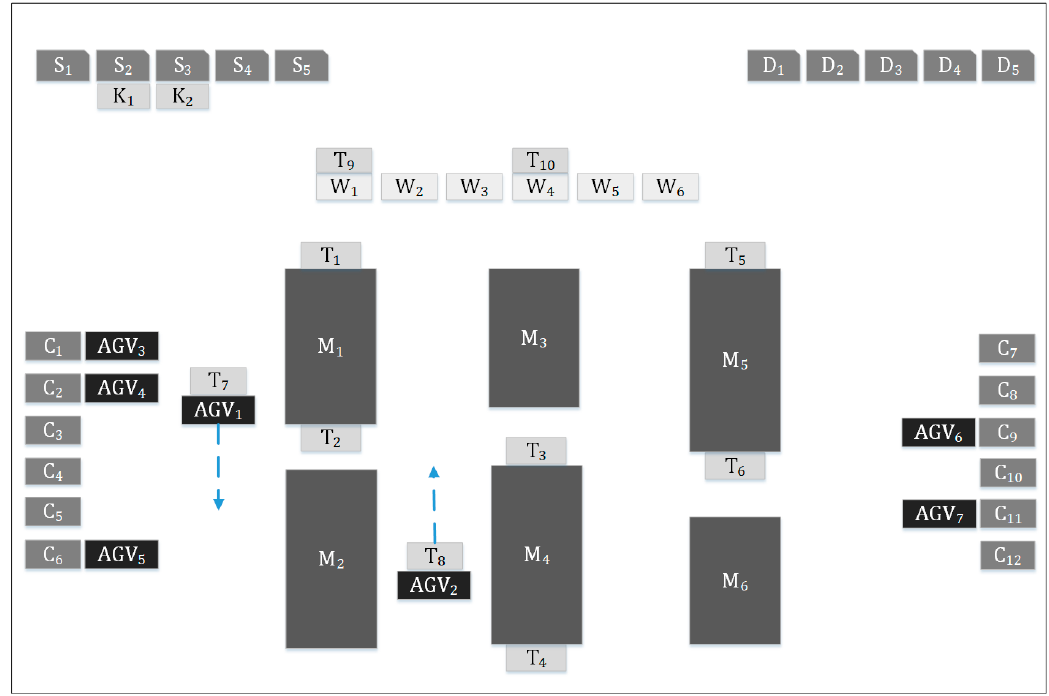
Figure 3. A minimized part of the modelled fabric finishing enterprise.